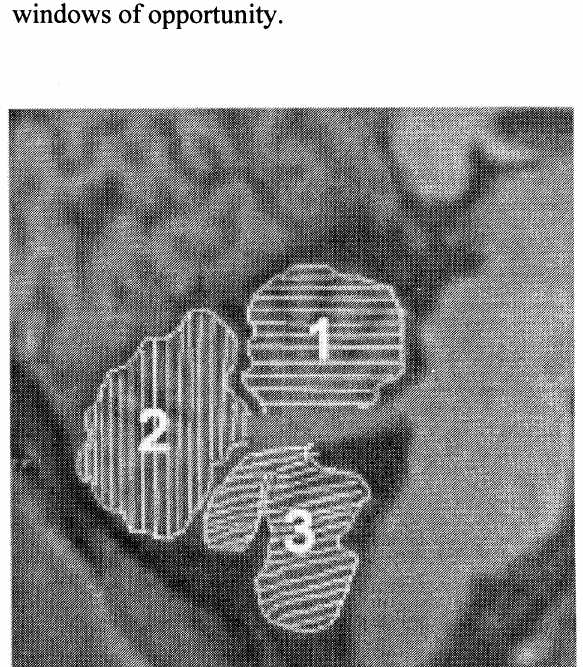
Fig. 1. Sagittal section of the cerebellum showing the folia of the vermis. MRI studies have revealed cerebellar hypoplasia associated with autism, schizophrenia, and ADHD. Interestingly, the regions showing hypoplasia differ for these disorders with the focus being in (1) Lobules to V in schizophrenia; (2) Lobules VI to VII in autism; (3) Lobules VIII to X in